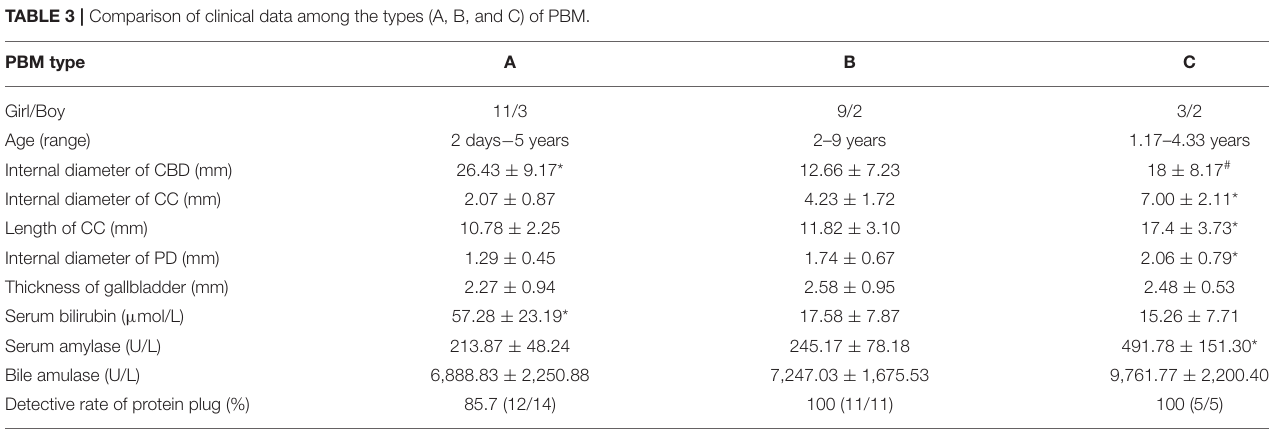
TABLE 3 | Comparison of clinical data among the types (A, B, and C) of